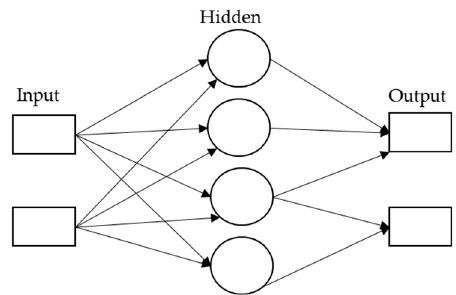
Figure 5. Neural network basic scheme.